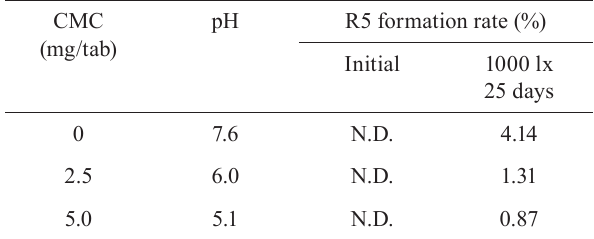
Table 5 R5 formation rate at different amounts of CMC in OD tablets.